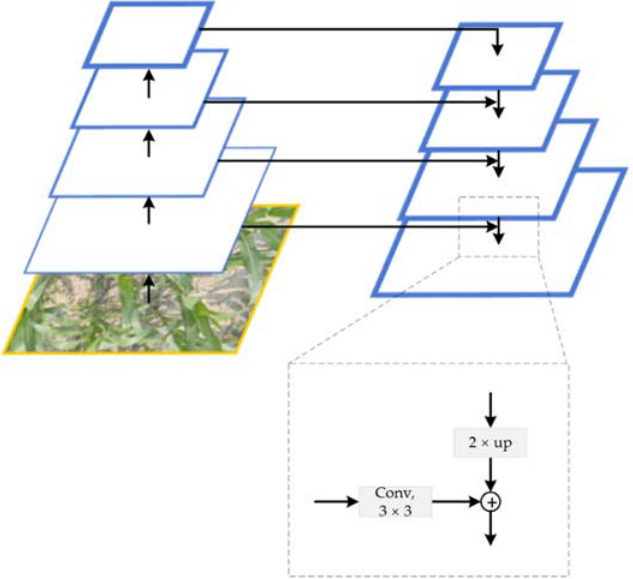
Figure 6. Illustration of FPN structure. Conv, 3 × 3 stands for a 3 × 3 convolutional block; 2 × up stands for the two times up ‐ sample operation for features maps extracted by the backbone network.